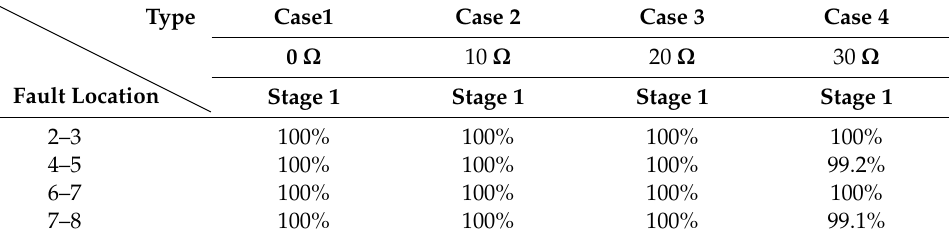
Table 6. Accuracy of the fault location according to measurement noises (fault in the main feeder).